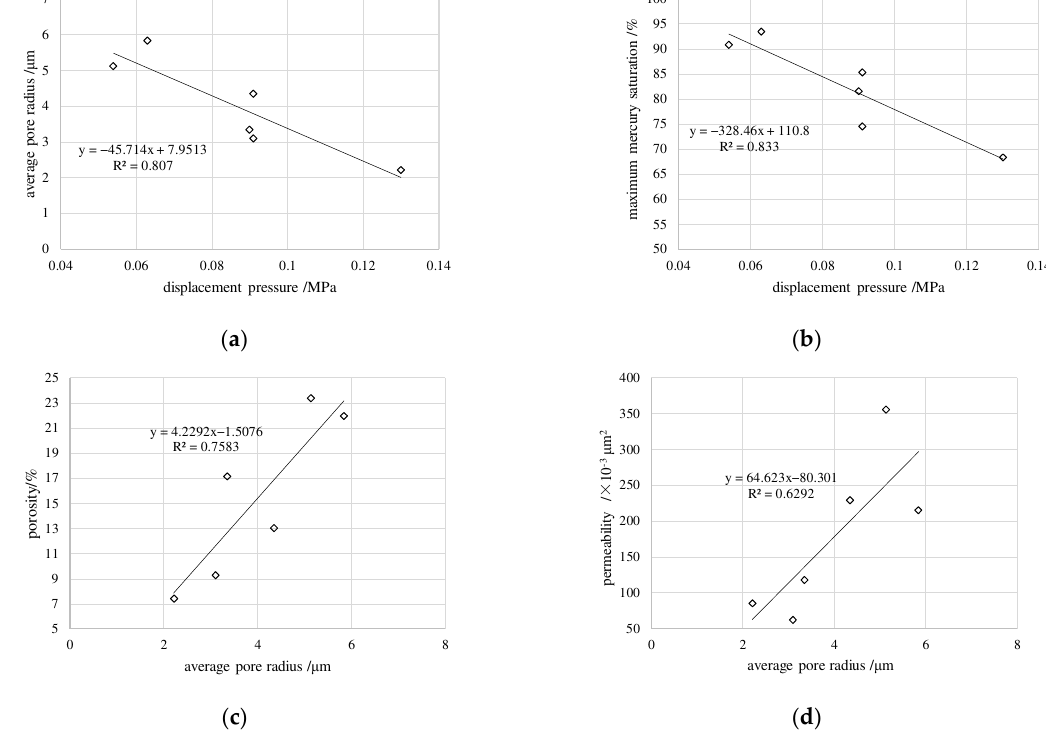
Figure 7. Mercury injection curves from pressure-controlled mercury injection of typical samples of Ek1 Formation in the Wang Guantun area. Table 2. Pore structure parameters of typical samples of Ek1 Formation in the Wang Guantun area.